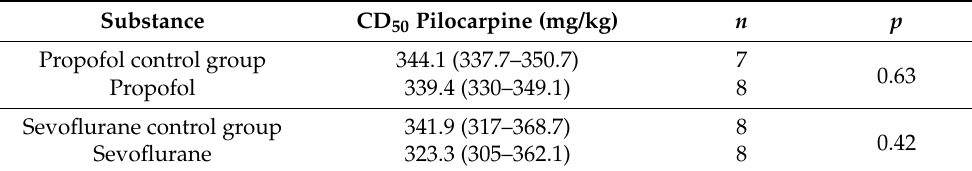
Table 1. Influence of propofol and sevoflurane administration during synaptogenesis on seizure threshold in pilocarpine model in adult